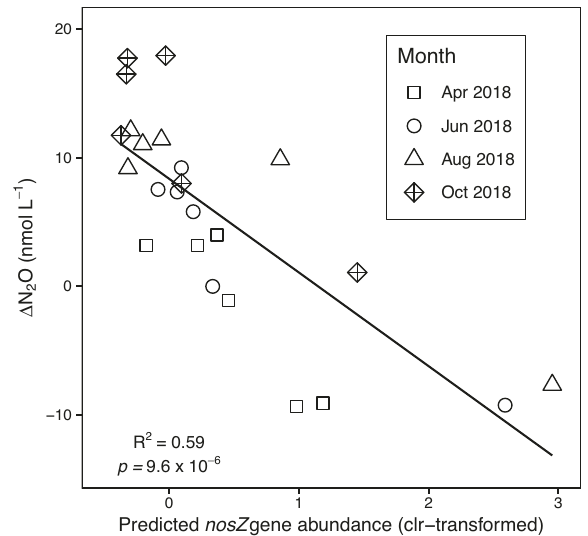
Fig. 6 Relationship between water column Δ N 2 O (nmol L − 1 ) and PICRUSt2-predicted bacterial nosZ gene abundances. NosZ gene abundances were inferred from the predicted KEGG orthologues across all 24 samples using bacterial 16S rRNA amplicon sequences as input to the PICRUSt2